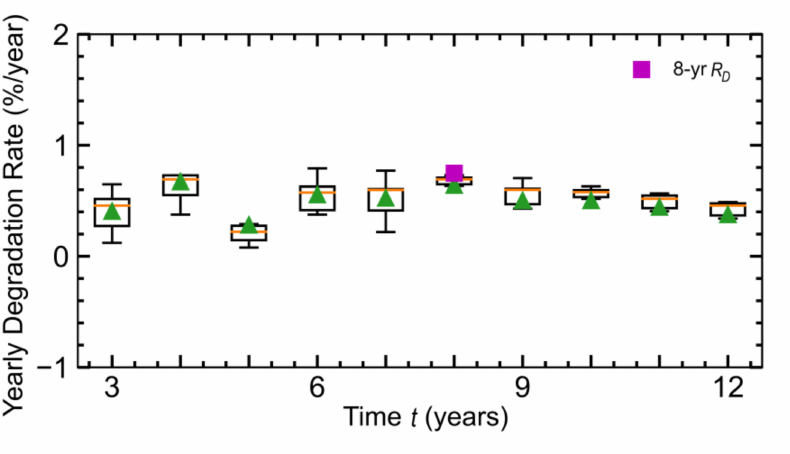
Figure 9. Box-plot of the course of the yearly R D calculated by applying time series analytical techniques, for the ase170Ni multi-c-Si PV system in Nicosia, Cyprus over the evaluation period of 12 years. The orange bar and green triangle depict the median and mean value, respectively. The purple square depicts the 8-year R D measured using indoor standardized